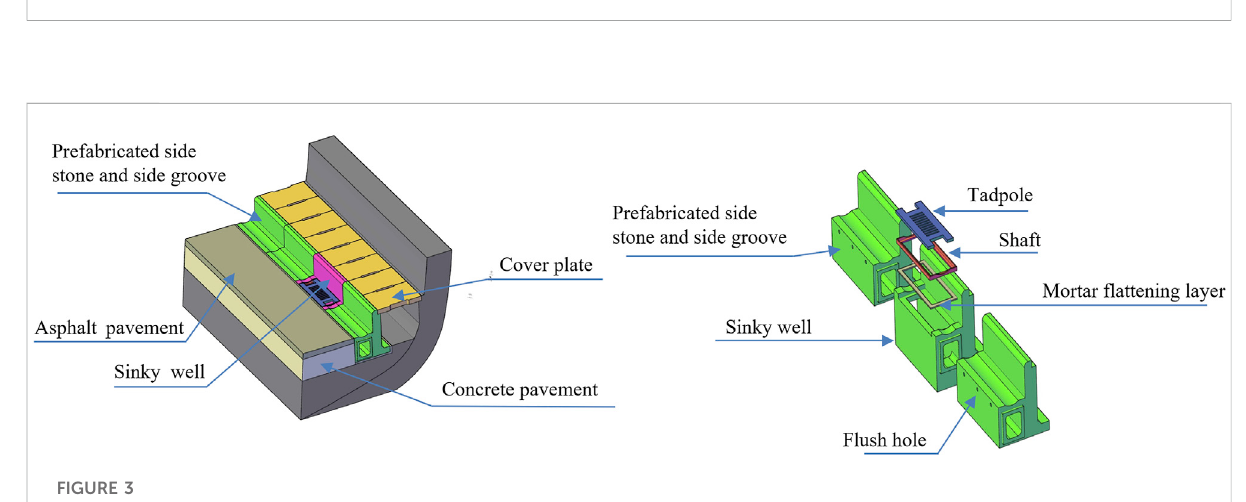
FIGURE 3 Three-dimensional structural drawing of the integral curb